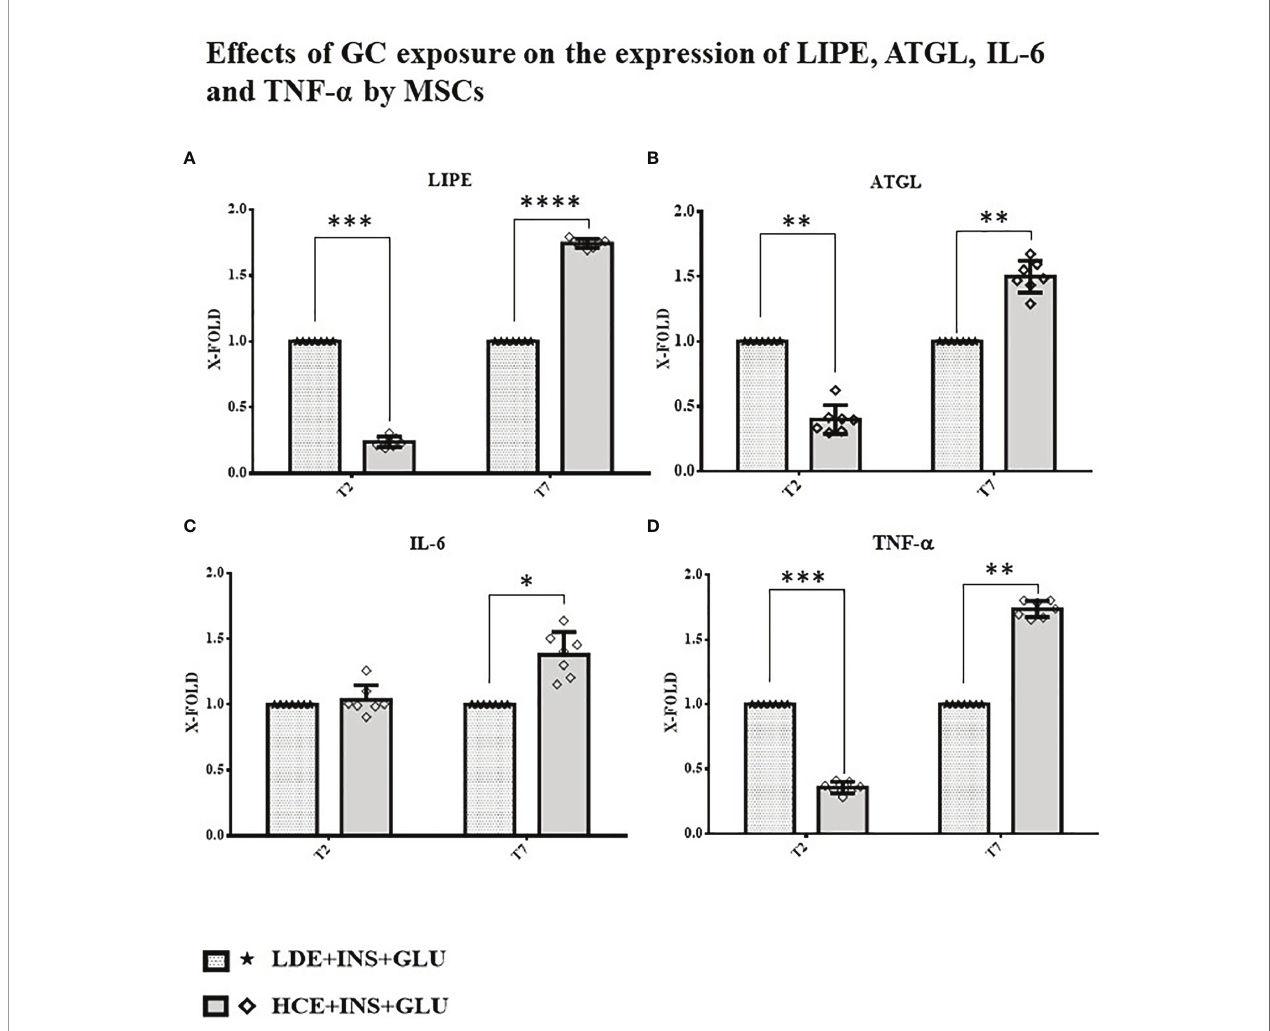
FIGURE 7 | Gene expression in MSCs undergoing a LDE or a HCE to GCs. The bars display the expression of genes referred speci fi cally to the development of IR: (A) : LIPE , (B) : ATGL , (C): IL-6 and (D): TNF- a at T2 and T7 sampling times. LDE+GLU+INS: LDE (Lower and Decreasing Exposure) cells stimulated with insulin before glucose exposure; HCE+GLU +INS: HCE (higher and Constant Exposure) cells stimulated with insulin before glucose exposure. Data are expressed as mean ± SD (over three independent experiments) of the X-fold (2 − DD Ct method) of HCE+INS+GLU compared to LDE+INS+GLU arbitrarily expressed as 1, where D Ct=Ct (gene of interest) — Ct (control gene) and D ( D Ct)= D Ct (HCE+INS+GLU) — D Ct (LDE+INS+GLU). Unpaired t-Student ’ s test; *p < 0.05,**p < 0.01,***p < 0.001; ****p <